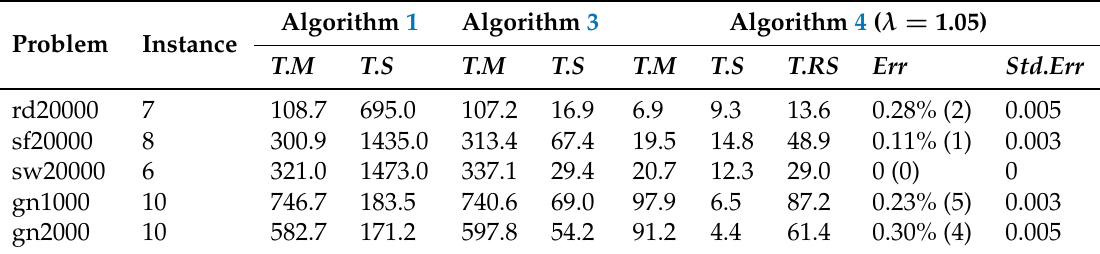
Table 4. The running time of the main parts and the error of Algorithm